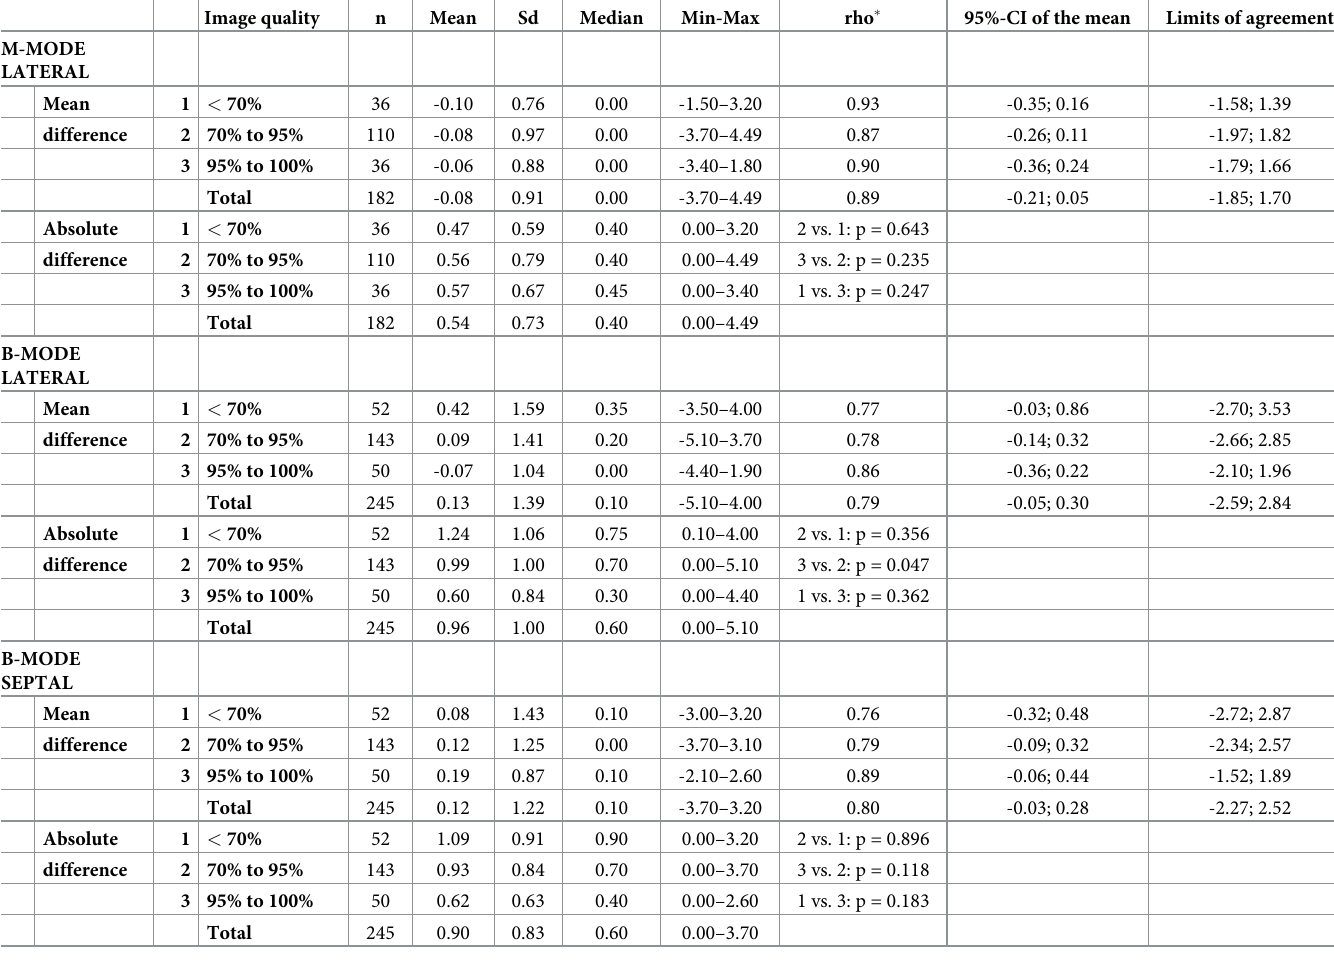
Table 4. Intraobserver reproducibility of MAPSE measurements in relation to echocardiographic image quality. P-values were calculated with the Mann-Whitney- U-Test. Image